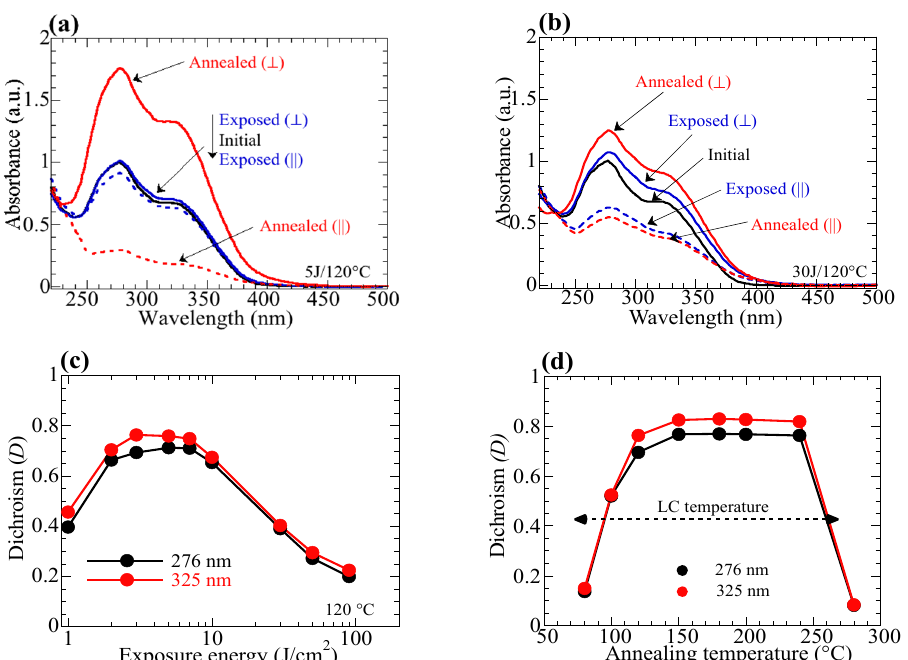
Figure 3. ( a , b ) Changes in the polarized absorption spectrum of P4 films upon exposure to linearly polarized 313 nm light. Exposure energy and the annealing conditions are ( a ) 5 and ( b ) 30 J/cm 2 and 120 ◦ C for 10 min, respectively. ( c , d ) Thermally stimulated D value change for the exposed P4 films ( c ) as a function of exposure energy of linearly polarized 313 nm light when the annealing temperature is 120 ◦ C and ( d ) as a function of annealing temperature when the exposure energy is 3 J/cm 2